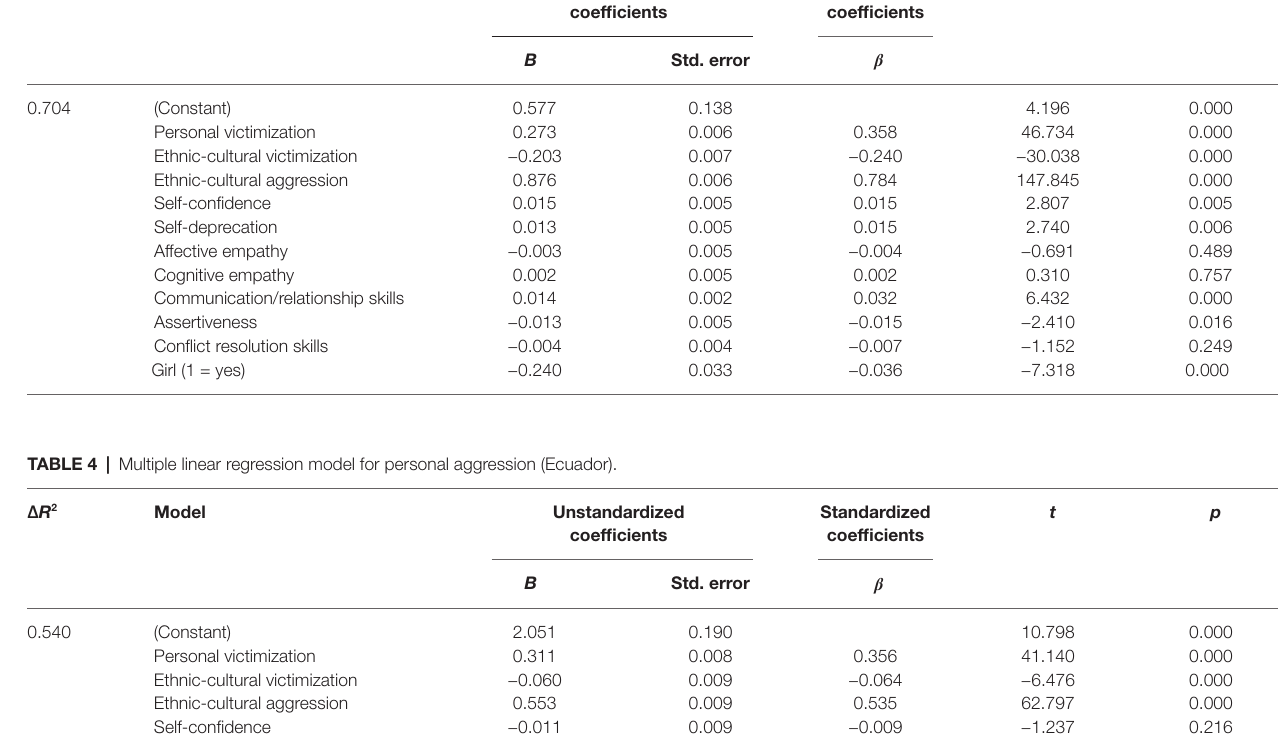
TABLE 3 | Multiple linear regression model for personal aggression (Spain). ∆ R 2